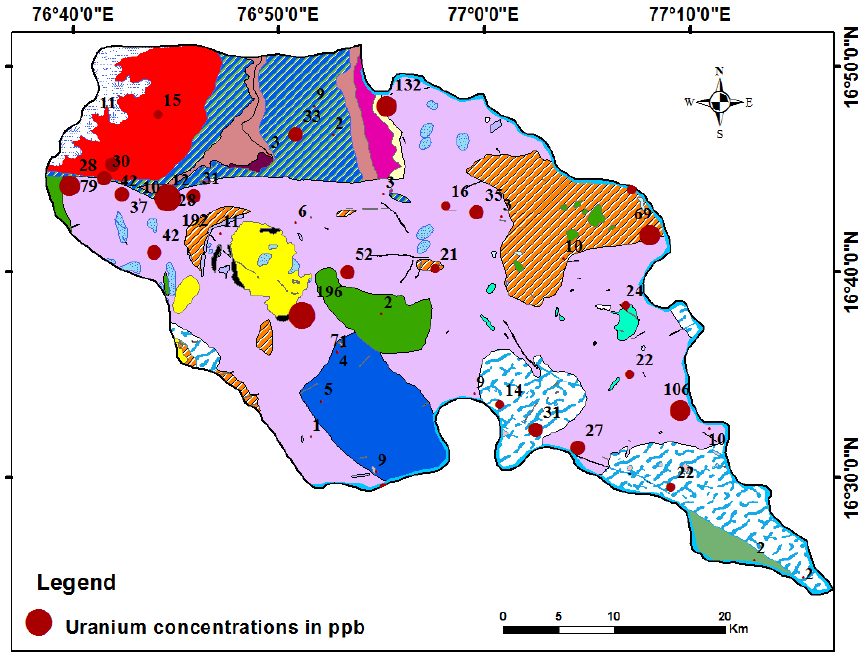
Figure 13. Average uranium concentration in the wells with concentration above 30 ppb.